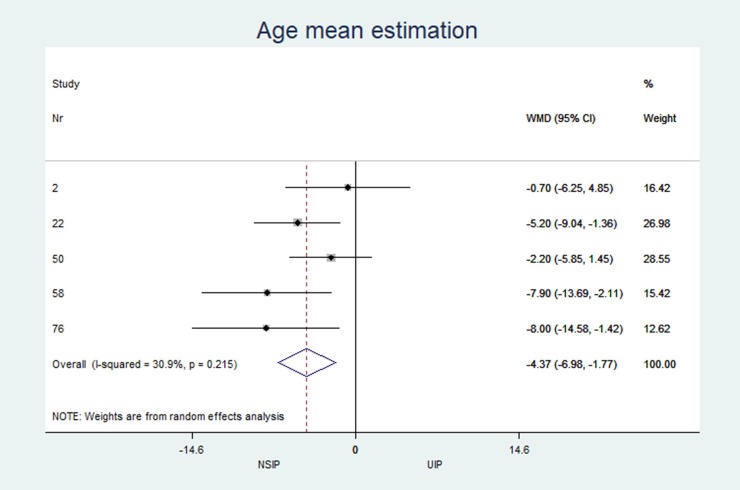
Mean age estimation.